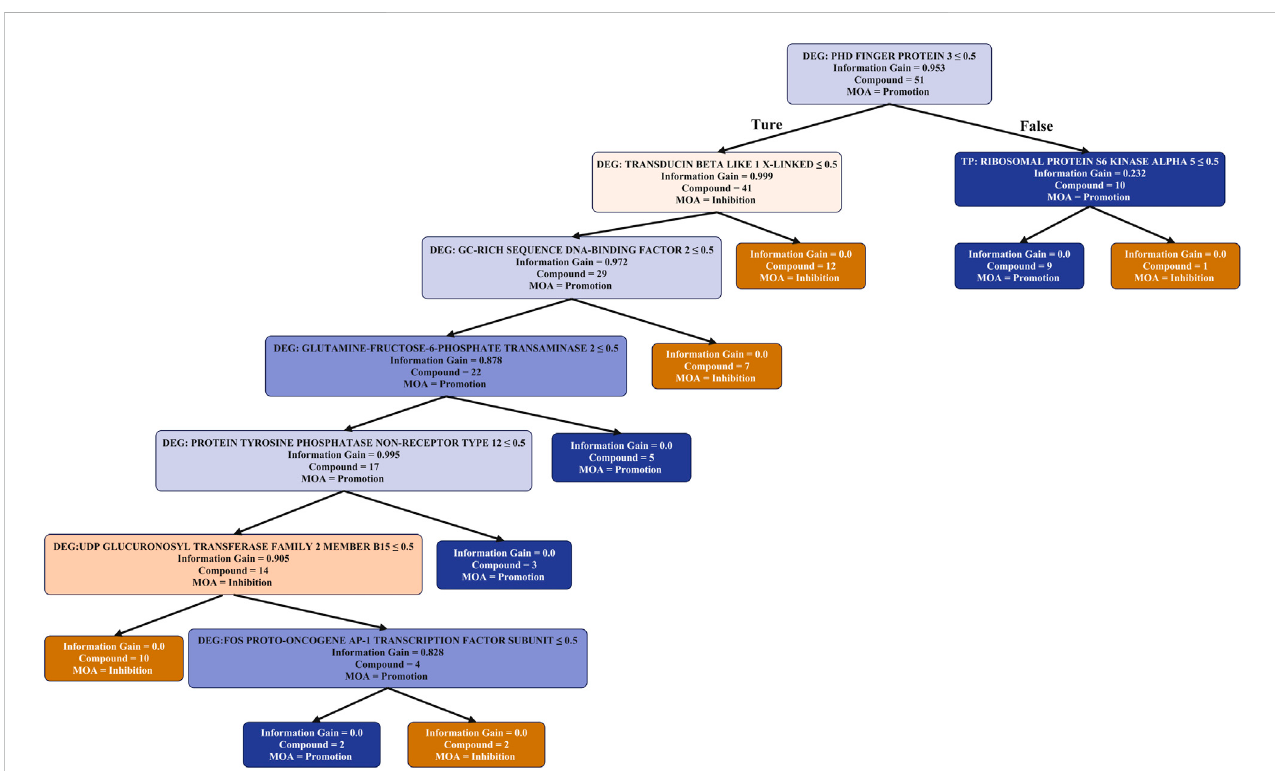
FIGURE 4 Mode of action analysis of individual pro- and anti-angiogenic metabolites derived from TCM, based on the most important ten predicted targets and DEGs. The numberofmetabolitesineachnode isshown, alongwith theentropy(theinformationgain)to denotethequalityofeachsplitinthetree.Colouris usedtoindicatethepurityforPROMOTER(blue)orINHIBITOR(orange)classi fi cationofmetabolites.ItcanbeseenthatbothDEGsandTargetpredictionwere selected by the decision tree as important features that can distinguish between inhibitors and